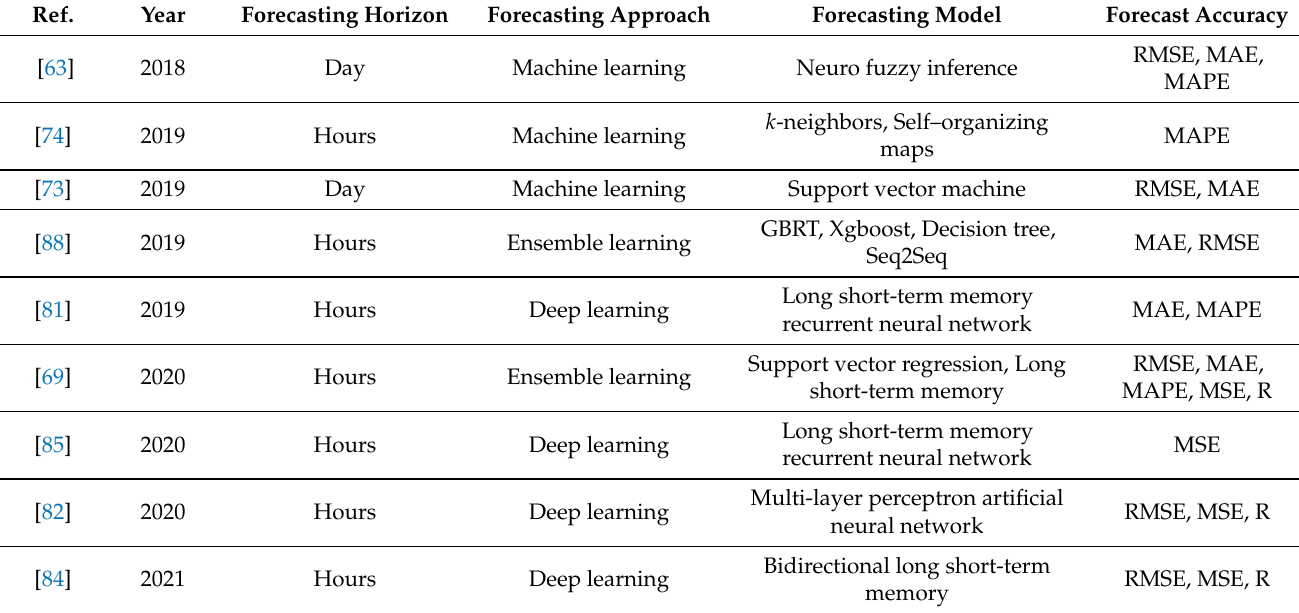
Table 4. Energy demand forecasting: a comparison of approaches.